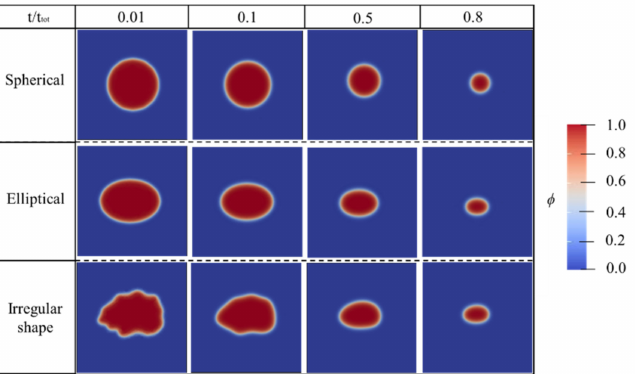
Figure 7. Snapshots corresponding to different time points in the dissolution profile of the NaCl crystal in 2D